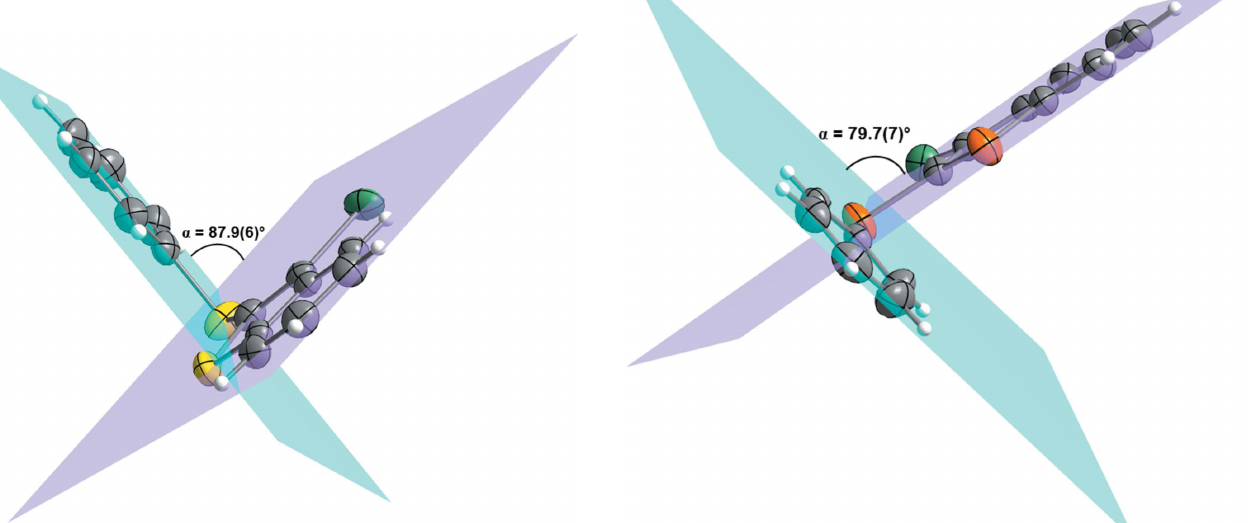
Figure 8 Representation of the interplanar angle ( (cid:4) ) between the planes containing the phenylselanyl, blue plane, and the benzo[ b ]selenophene, purple plane, groups for 3-iodo-2-(phenylselanyl)benzo[ b ]selenophene ( 4 ). Displacement ellipsoids are drawn at the 50% probability level. Gray: carbon; orange: selenium; bluish green: iodine; white: